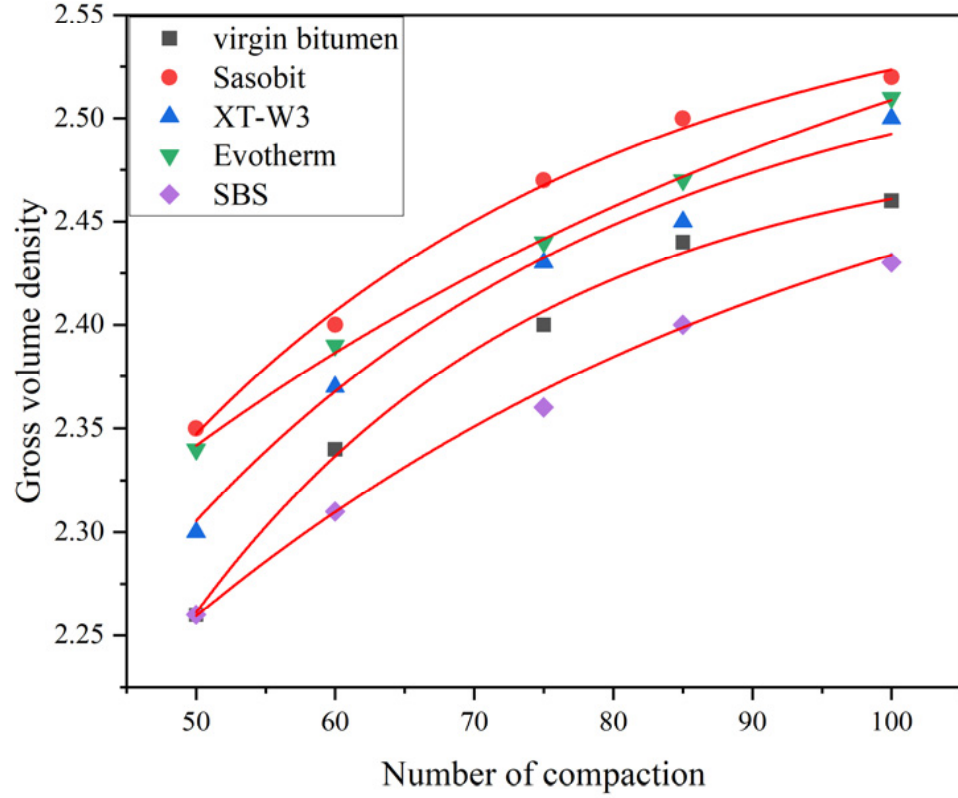
Figure 9. Relationship between gross volume density and number of compactions.